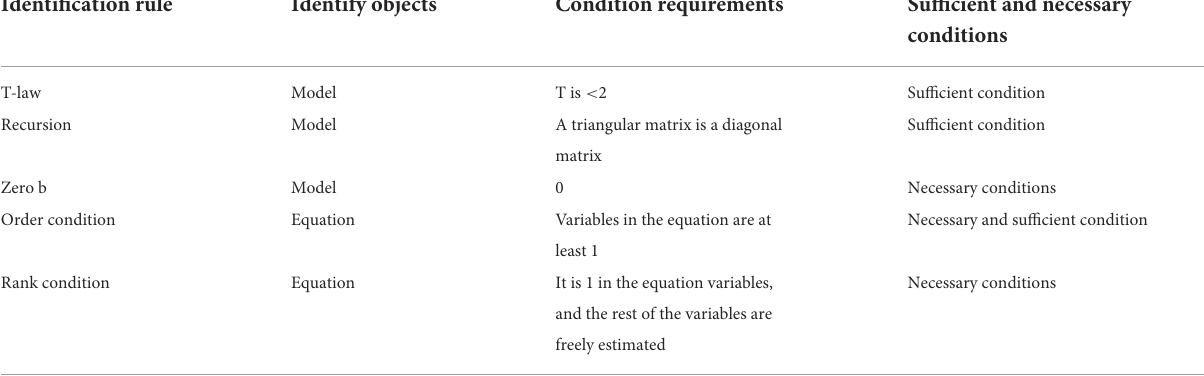
TABLE 1 Causal model conditions.